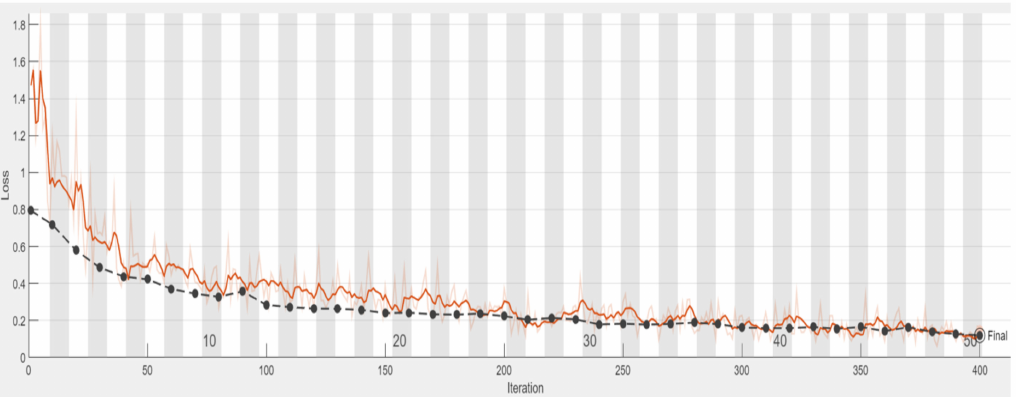
Figure 11. The accuracy of Alexnet model in test set (black line) and training set (orange line) during loss training